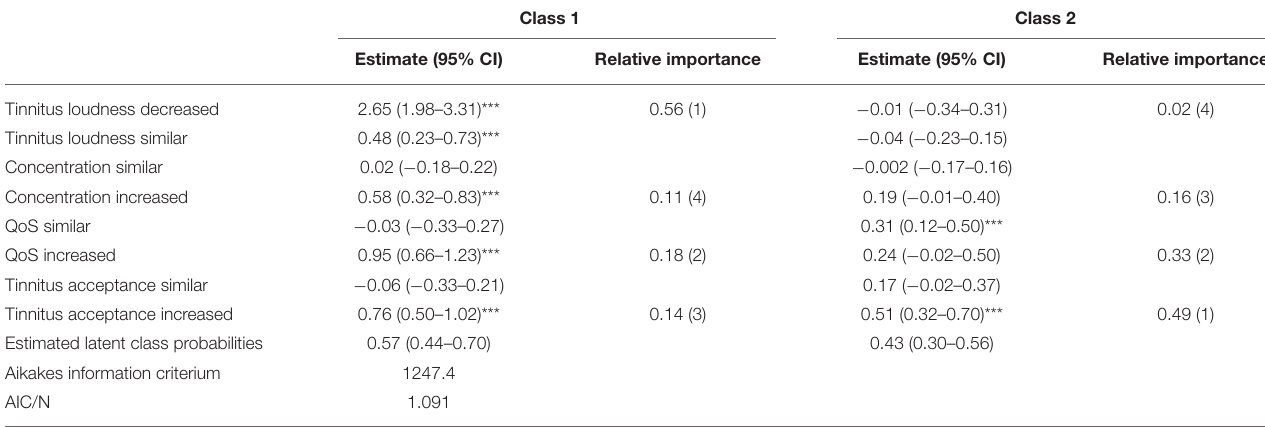
TABLE 5 | Outcome of the latent class